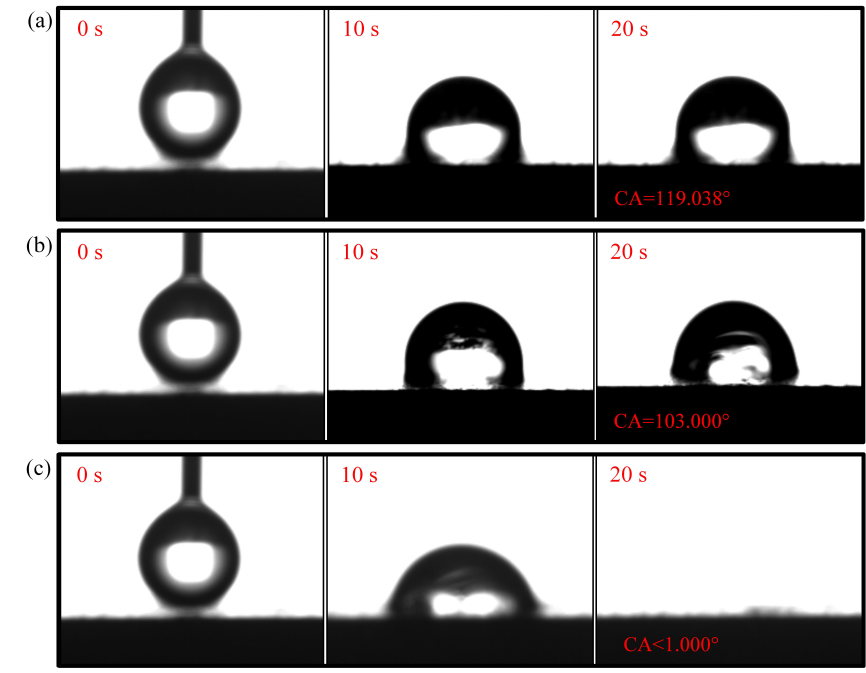
Figure 7. Wettability test of 1-CCC: ( a ) α region; ( b ) β region; ( c ) γ region.